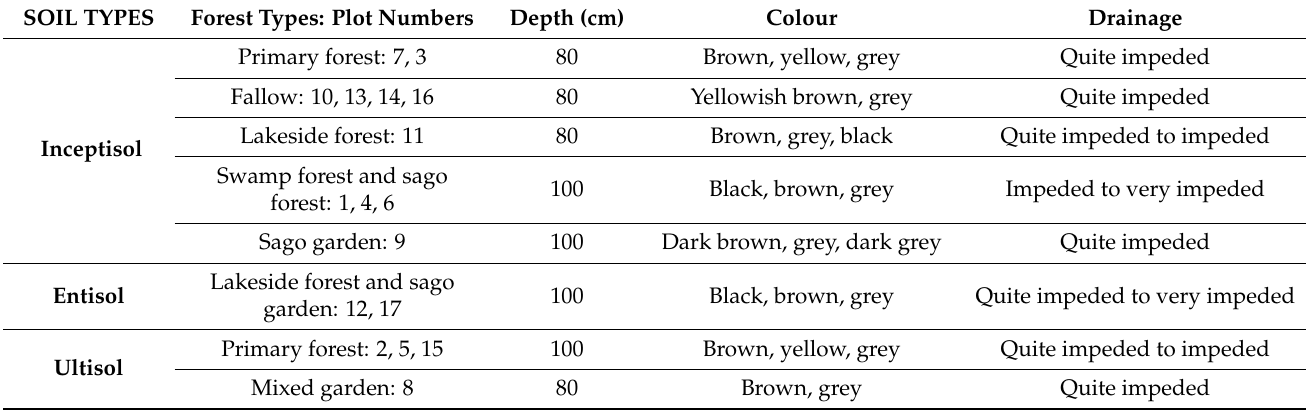
Table 5. Soil properties in the Mamberamo Basin as described by visible characteristics.